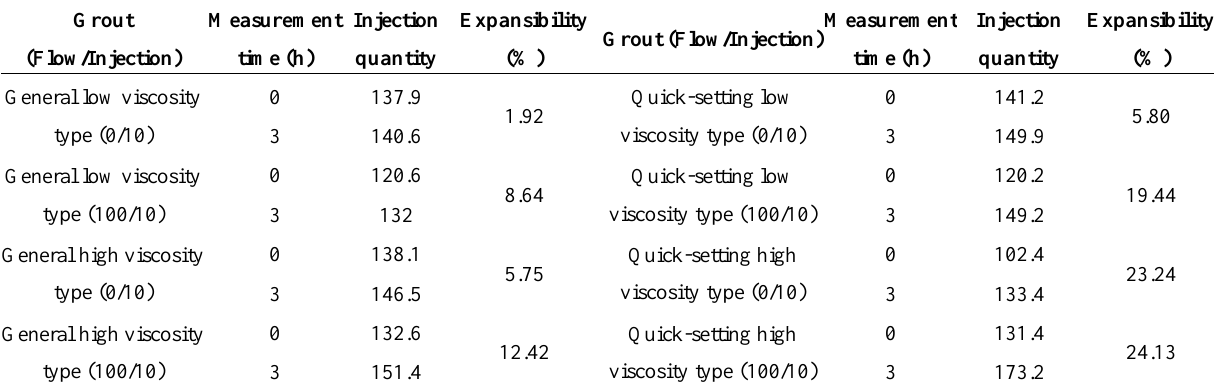
Table 4. Expansibility of grout measured over time.